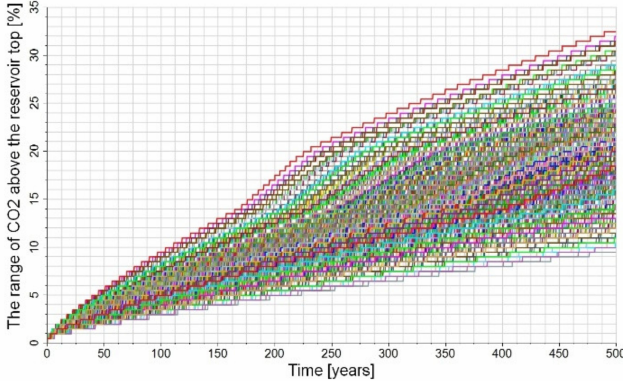
Figure 19. The distance of CO 2 migration in the overburden vs. time. Ensemble no.